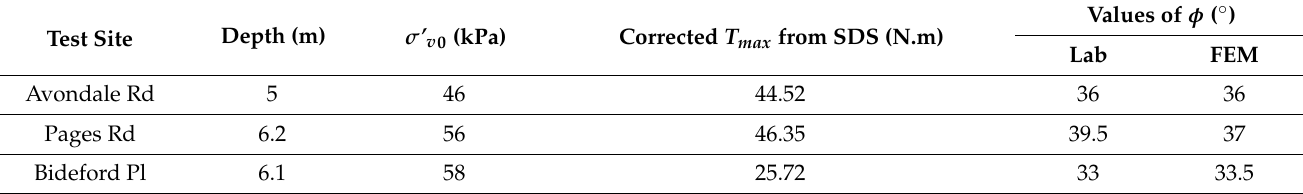
Table 3. Comparison between the predicted friction angles from the FE model and laboratory- measured peak friction